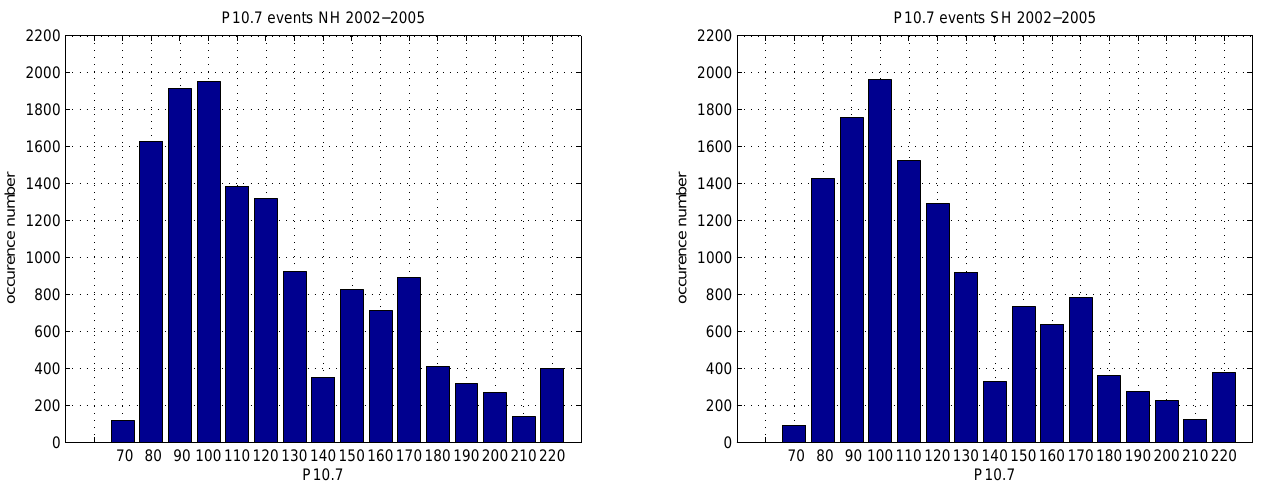
Fig. 3. Occurrence distribution of density anomaly detections at different P10.7 levels. In the bar P10.7 = 220 all events from higher flux levels are accumulated.